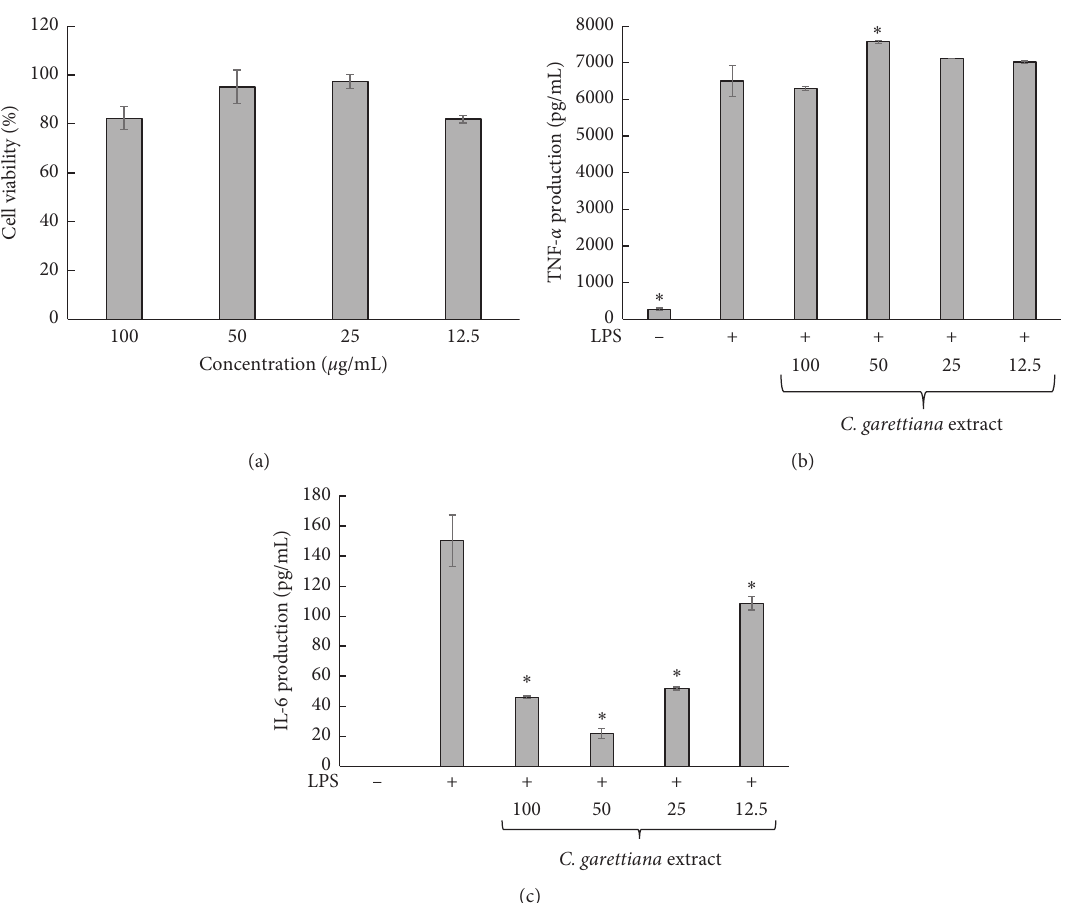
Figure 2: Effect of C. garettiana extract on RAW264.7 cell viability (a), TNF- α production (b), and IL-6 production (c). ∗ p < 0 . 05 when compared with LPS-stimulated